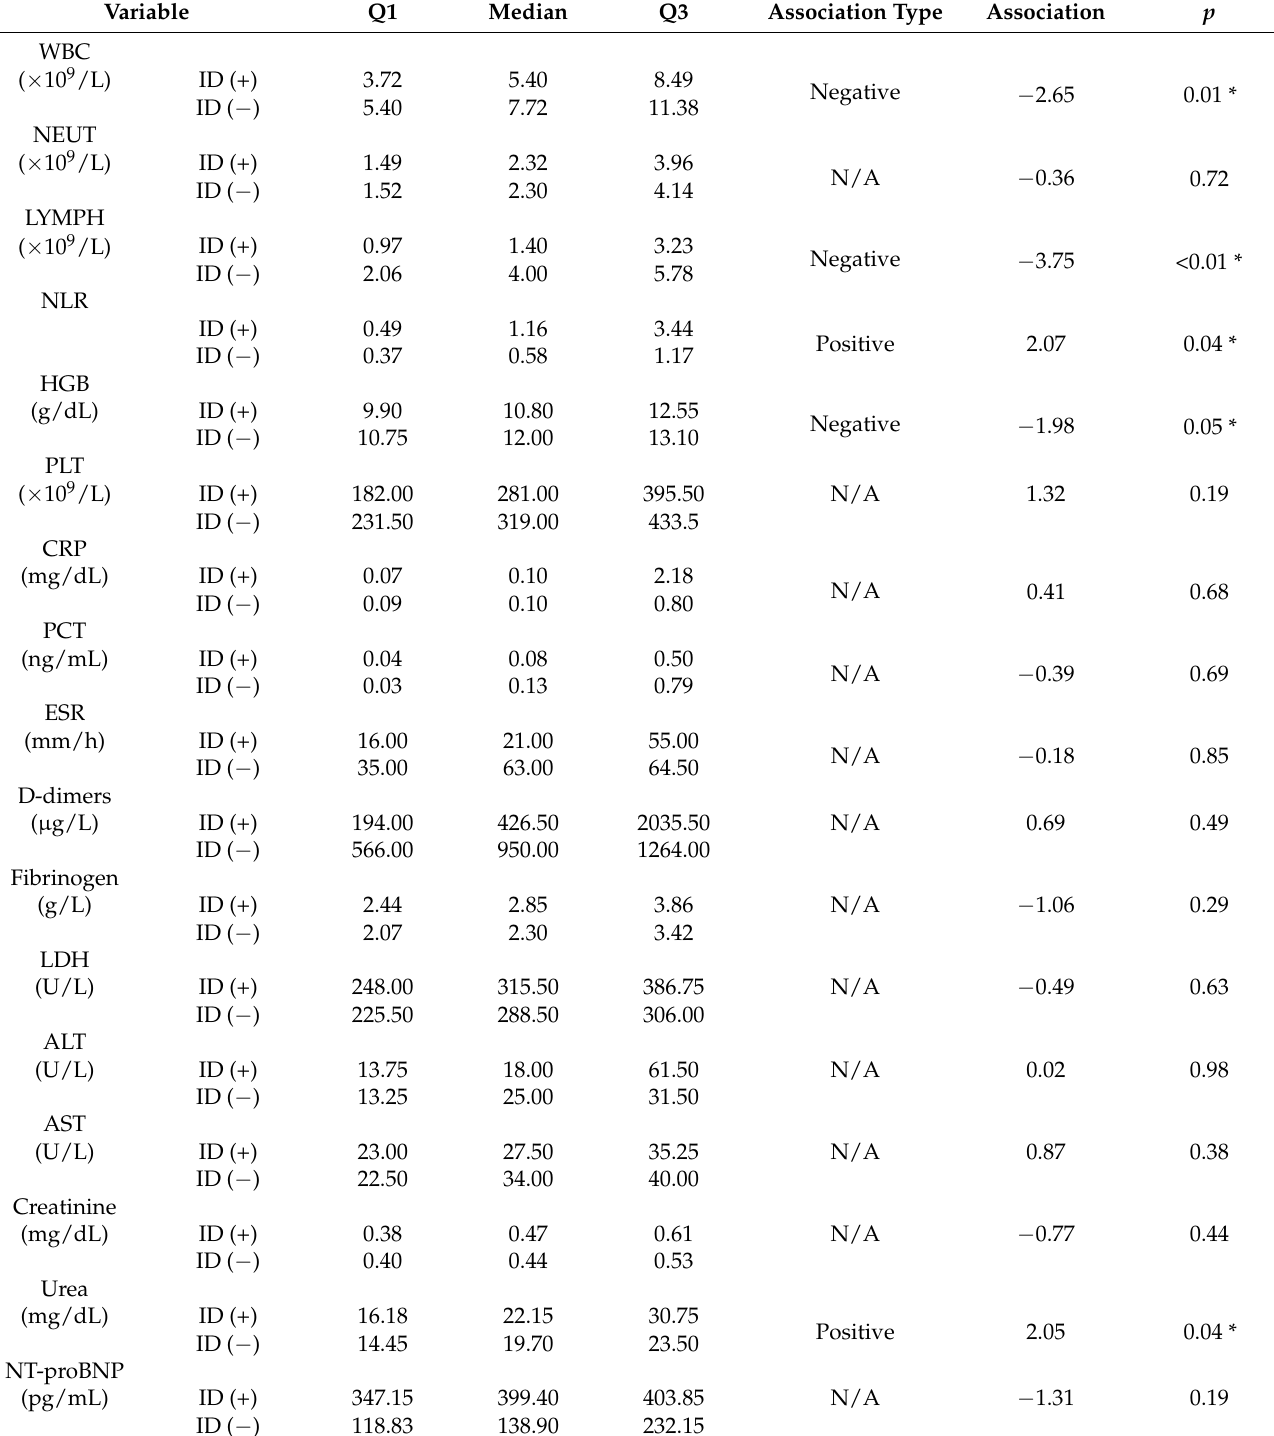
Table 6. Comparison of the laboratory test results in children with and without